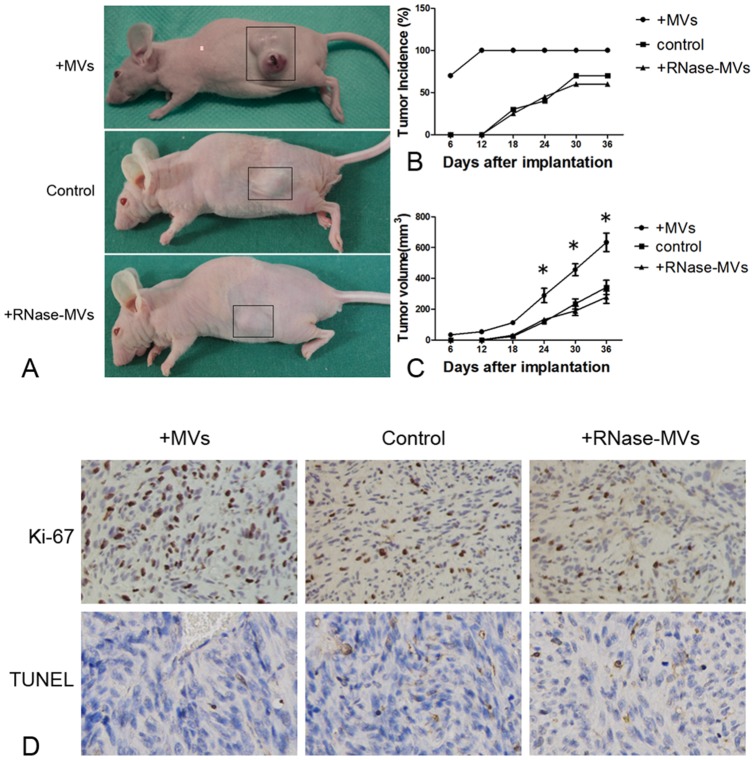
MVs facilitate the growth of inoculated tumors.
(A) Nude mice inoculated with 786-0 cells. 786-0 cells mixed with MVs or RNase-MVs in M199 or M199 (control) were inoculated subcutaneously in the nude mice sacrificed at 36d following inoculation; (B) Tumor incidence. There was a higher tumor incidence in nude mice treated with MVs as compared to RNase-MVs or control; (C) Tumor volume. In contrast to RNase-MVs or control, MVs led to the development of a bigger tumor in nude mice. *P<0.05, MVs vs. RNase-MVs or control; (D) Ki-67 and TUNEL staining. In the presence of MVs, there were more Ki-67-positive staining cells and fewer cells staining positive for TUNEL on tumor sections.